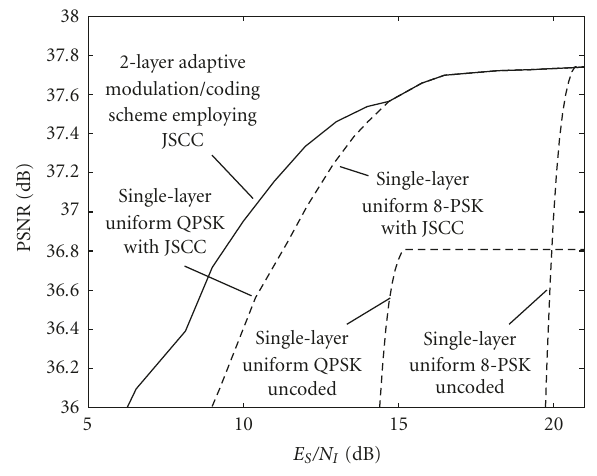
Figure 11: PSNR as a function of E S /N I in dB for 2-layer adaptive modulation and coding scheme for AWGN channel. Fixed symbol transmission rate r S = 128Ksps.